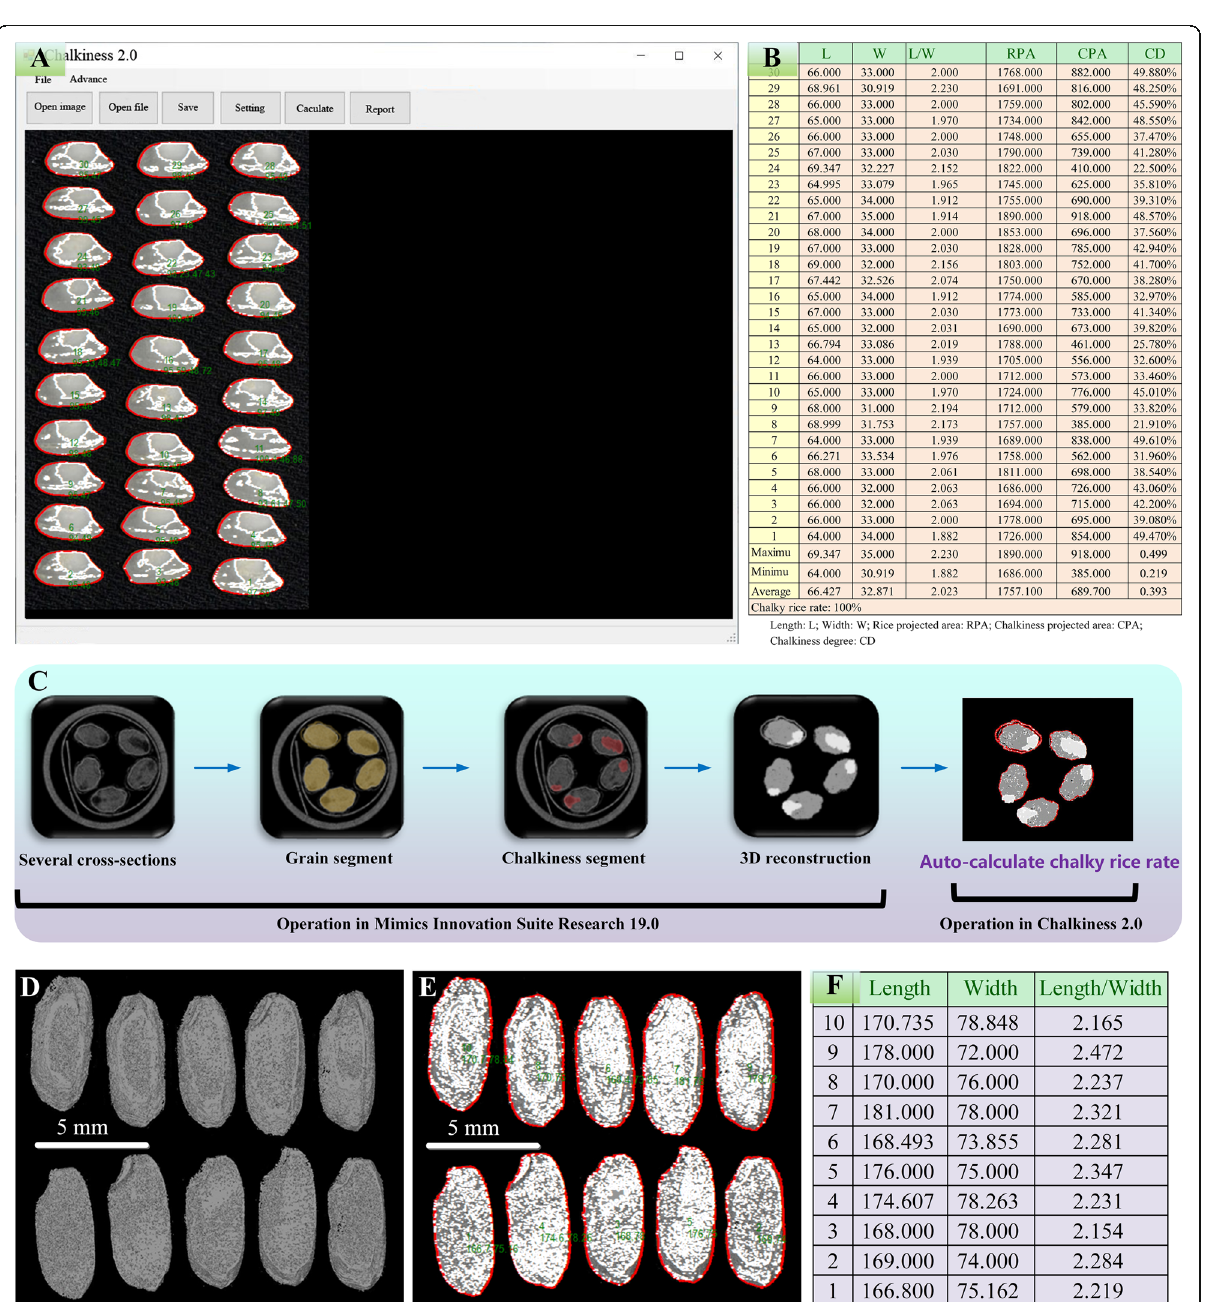
Fig. 6 Auto-calculation of chalky rice rate and rice grain size by using micro-CT 3D reconstruction coupled with Chalkiness 2.0 software. a Scanned image of milled rice (Zhenshan 97B) imported in Chalkiness 2.0 software, and the rice grain and chalkiness were auto-regionalized; b The chalkiness related parameters were auto-calculated, and the test report was exported into an Excel format file; c Graphical overview of auto-calculating chalky rice rate based on micro-CT 3D reconstruction coupled with Chalkiness 2.0 software. d 20 cross-sections near the maximum section were reconstructed and a plane image was generated; e The plane image was import to Chalkiness 2.0 for grain size evaluation; f The quantitative results were exported into an Excel file. The values represent the relative length and